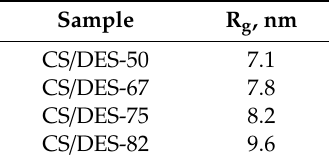
Table 1. The size of inhomogeneities (R g ) estimated from the slope of the initial portion of scattering curves plotted in Guinier coordinates.